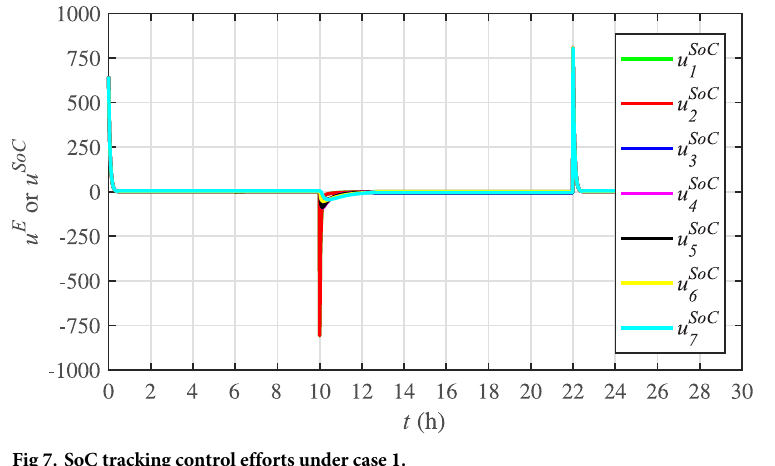
Fig 7. SoC tracking control efforts under case 1.